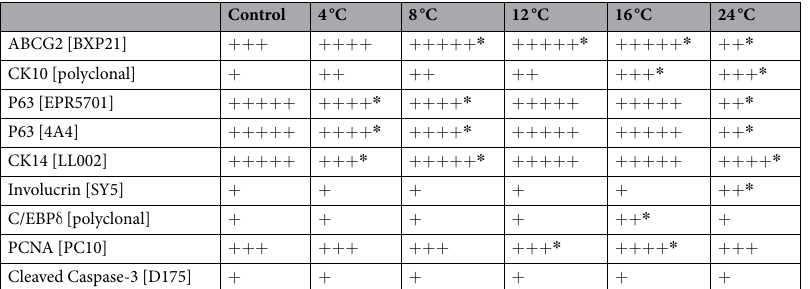
Table 1. Percent Positive Cells (Immunocytochemistry). * Significantly different compared to control (p ≤ 0.05). + = present. ++ = 20–39%. +++ = 40–59%. ++++ = 60–79%. +++++ =